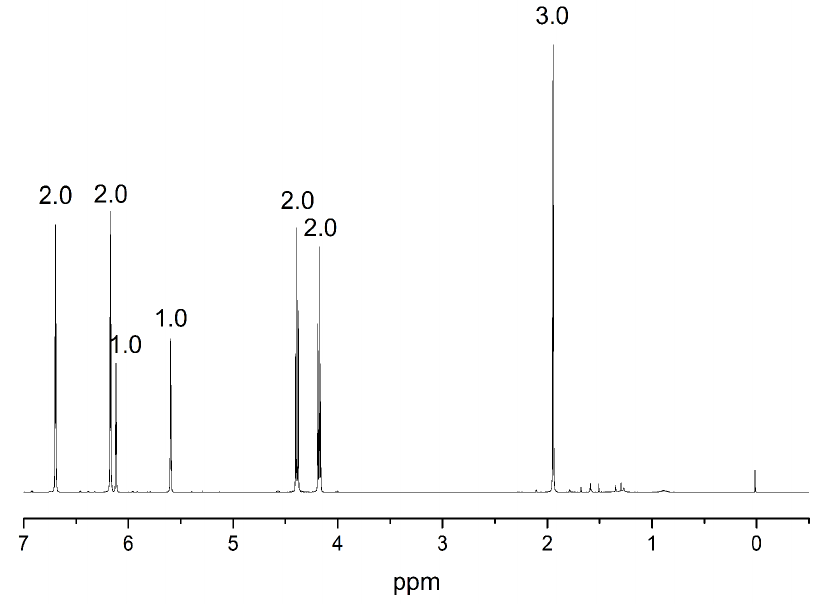
Figure 8. 1 HNMR spectrum of the 2 ‐ (1H ‐ pyrrole ‐ 1 ‐ yl)ethyl methacrylate (PyEMA).